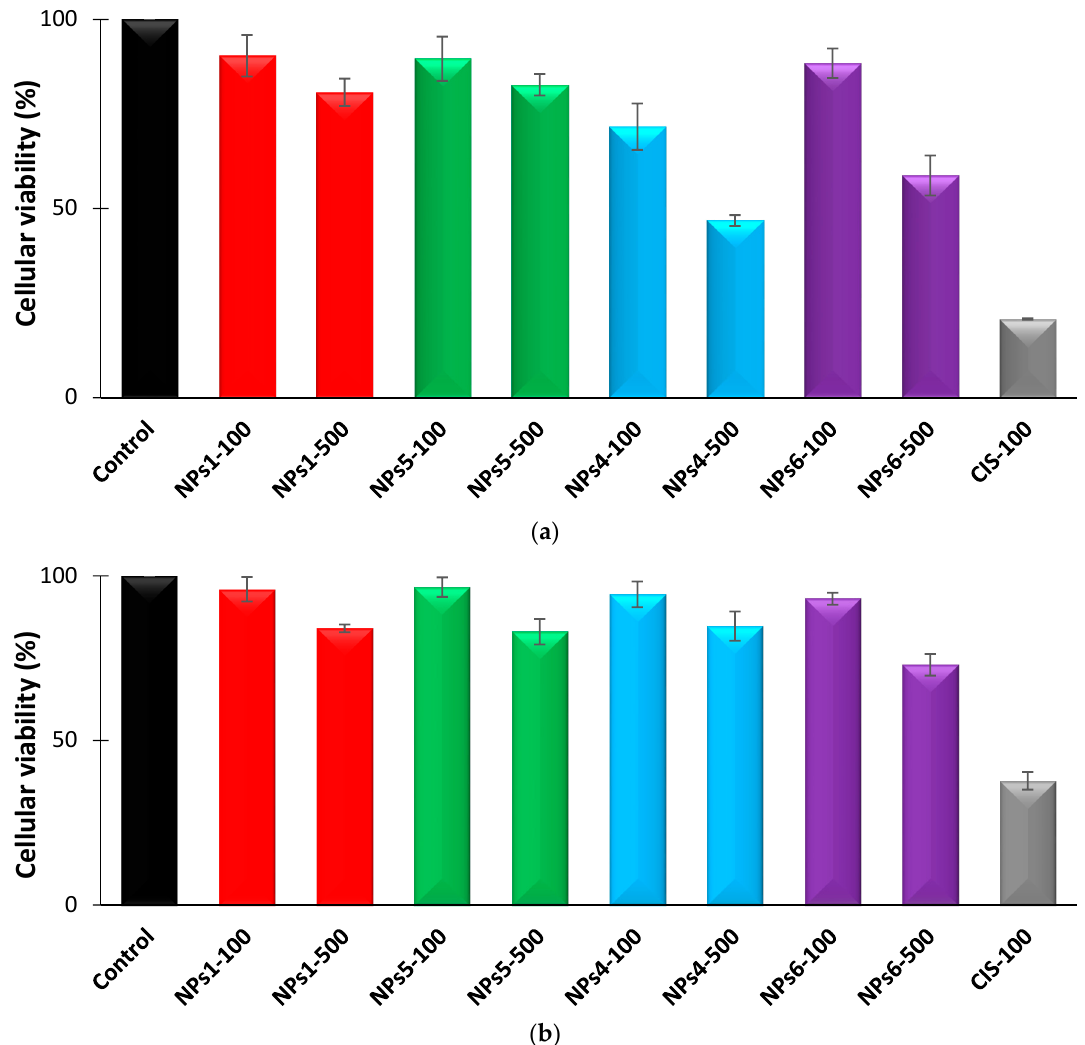
Figure 4. Evolution of the cellular viability after a treatment of 48 h with different NPs samples at two concentrations, 100 and 500 μ g/mL. ( a ) A375 and ( b ) MCF7 tumor cells.